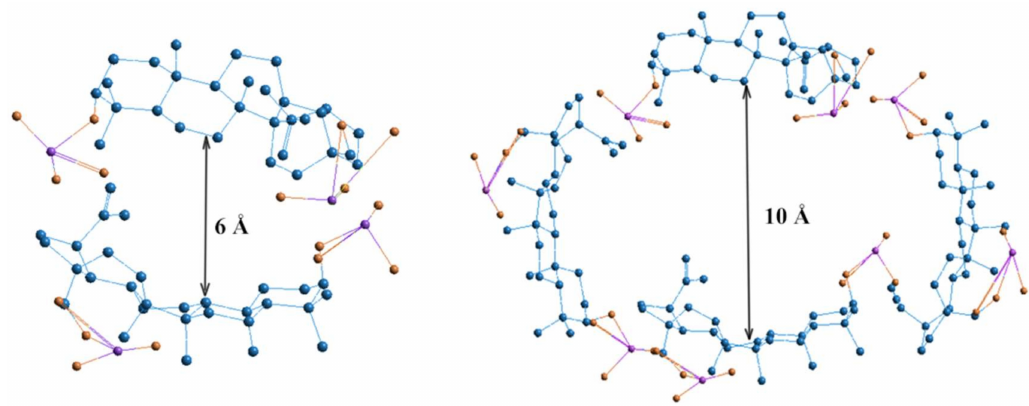
Figure 3. Geometric visualization of BDP as a component of inclusion complexes formed by two and four molecules. Quantum-chemical calculations were provided by HyperChem 8.0, Hypercube Inc, Gainesville, FL, USA (semiempirical method AM1). Size of the void between BDP molecules is 6 Å for dimer and 10 Å for tetramer [27]. Table 6. Lactate dehydrogenase activity (% of control) in direct and reverse reactions under the action of 5-FU, HS, BDP, BDP + 5-FU, and BDP + HS at the doses of 2, 5 and 10 µ g · mL − 1 . Index, % of Control Dose ( µ g · mL − 1 ) LDH direct LDH reverse 2 99 ± BDP